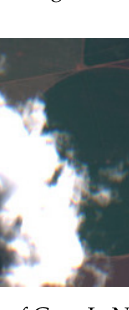
Figure 11. Examples of missed detections after the recognition of GoogLeNet.